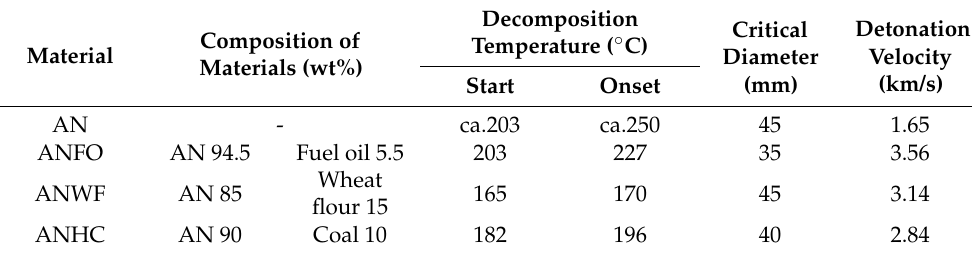
Table 9. Measurements of explosivity parameters for pure AN and mixtures of AN with vegetable substances. [44].